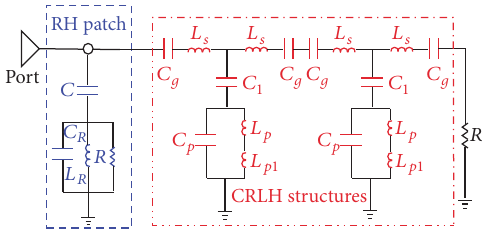
Figure 3: Illustration of the hybrid resonant equivalent circuit